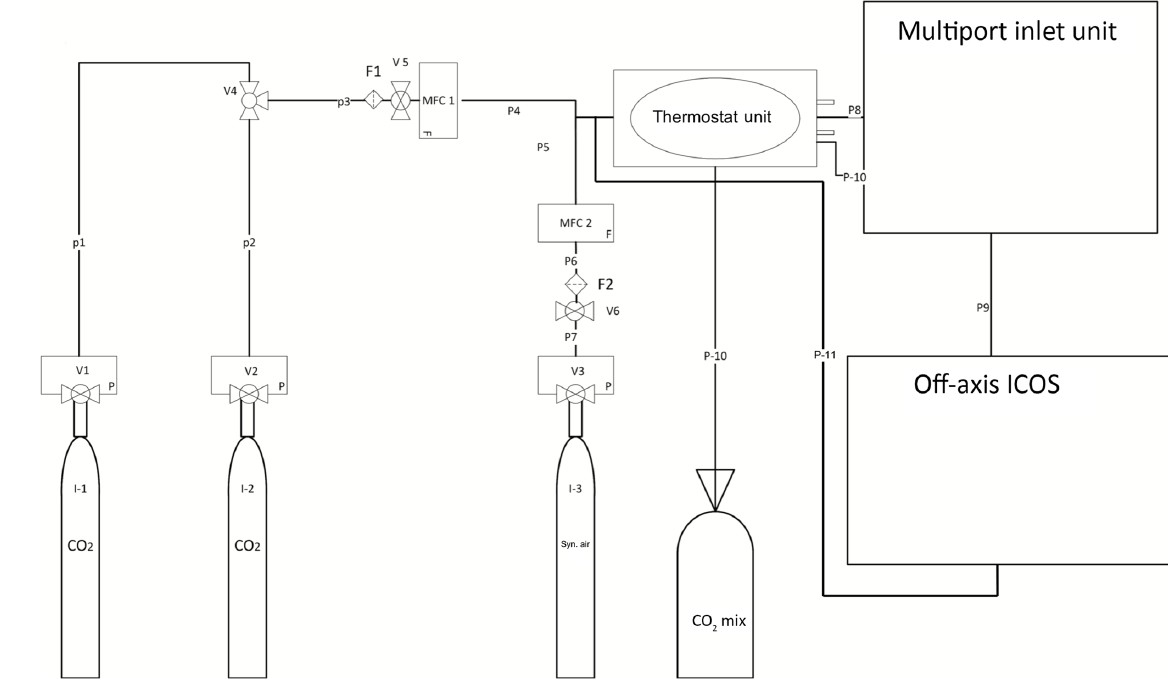
Figure 1. Set-up made for calibration of OA-ICOS (LGR CCIA 36-d). I (1, 2) represents CO 2 standards, CO 2 mix denotes gas standards mixed in equal molar proportion, I3 represents synthetic air, MFC (1, 2) denotes mass flow controller, F (1, 2) represents PTFE filter, V (1, 2, 3) denotes pressure-reducing valves, V4 shows three-way ball valve, V (5, 6) stands for pressure controller valve with safety bypass, P (1–7) denotes steel pipes, and P (8–11) represents Teflon